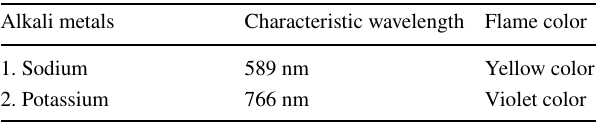
Fig. 1 Map showing the locations of collected water samples in and around Dhanbad city Table 1 Characteristic emission color from alkali metals under the flame Alkali